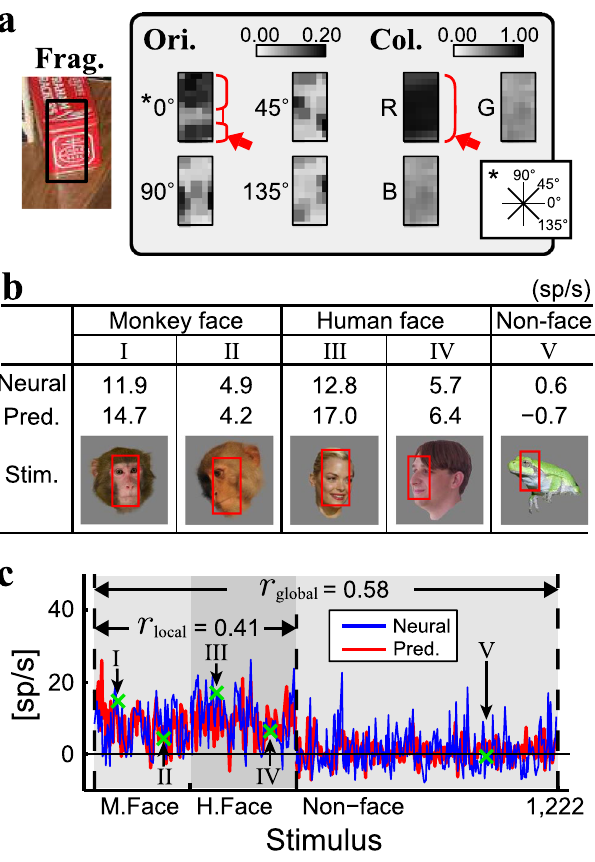
Figure 3. Example feature candidate found to describe the neural responses recorded from site S1_a. ( A ) This feature candidate was originated from the fragment of a red snack box image (black rectangle). “Ori.” and “Col.” refer to the orientation and color channels, respectively. ( B ) Five example stimuli whose neural responses were located in the first and third quartiles among the monkey faces (“I” and “II”), the same quartiles among the human faces (“III” and “IV”), and the median among non-faces (“V”). The predicted responses for these stimuli are denoted by green “x” marks in (C). In the images, the red rectangles denote the sub-region that showed the best match with the feature candidate. The numbers indicate neural (above) and predicted (below) responses. sp/s: spikes/s. ( C ) The neural response from site S1_a (red line), and predicted responses generated from the candidate (blue) (vertical axis) plotted against stimuli grouped by stimulus categories (horizontal axis). M.face, H.face, and Non-face indicate categories of monkey faces, human faces, and non-face objects, respectively. Please note that the predicted responses ranging from 0 to 1 were converted to spike rates using the mean value of the face responses and of the non-face object responses (see